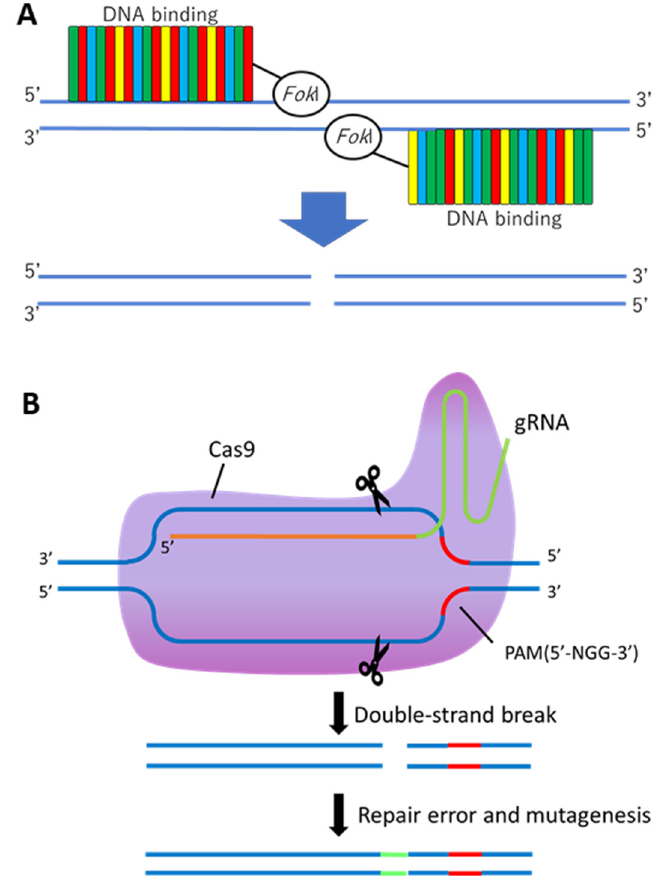
Figure 1. ( A ) A scheme of the TALEN architecture and genome-editing mechanism. Transcription activator-like effector nucleases (TALEN) are chimeric protein that works in pairs composed by a TAL effector DNA-binding domain merged to a nuclease domain from the Fok I restriction enzyme. The TALEs have highly conserved and repetitive peptide modules containing up to 34 amino acids (represented by the colored bars). Each TALE repeat specifically recognizes one of the nucleotide bases, and multiple TALE repeats are combined to target a specific DNA sequence and generate a DNA double-strand break by Fok I action within the intervening spacer region. ( B ) Overview of CRISPR/Cas9-mediated genome-editing mechanism for non-homologous end joining (NHEJ) repair. Guide RNA (gRNA) is designed to recognize the target sequence located upstream of the protospacer-associated motif (PAM), NGG in the case of CRISPR/Cas9, which serves as a binding signal for Cas9. When nucleotide base pairing occurs (due to the annealing of the target sequence with the protospacer region of the gRNA, represented in the figure by an orange line), the Cas9 enzyme is activated, causing DNA double-strand break. The breaks activate the intracellular repair systems of the cell, which convert breaks into insertion or deletion mutations. The mutations generally cause sequence failures and generate non-functional proteins. CRISPR-associated protein 9 (Cas9); guide RNA (gRNA); protospacer adjacent motif (PAM).